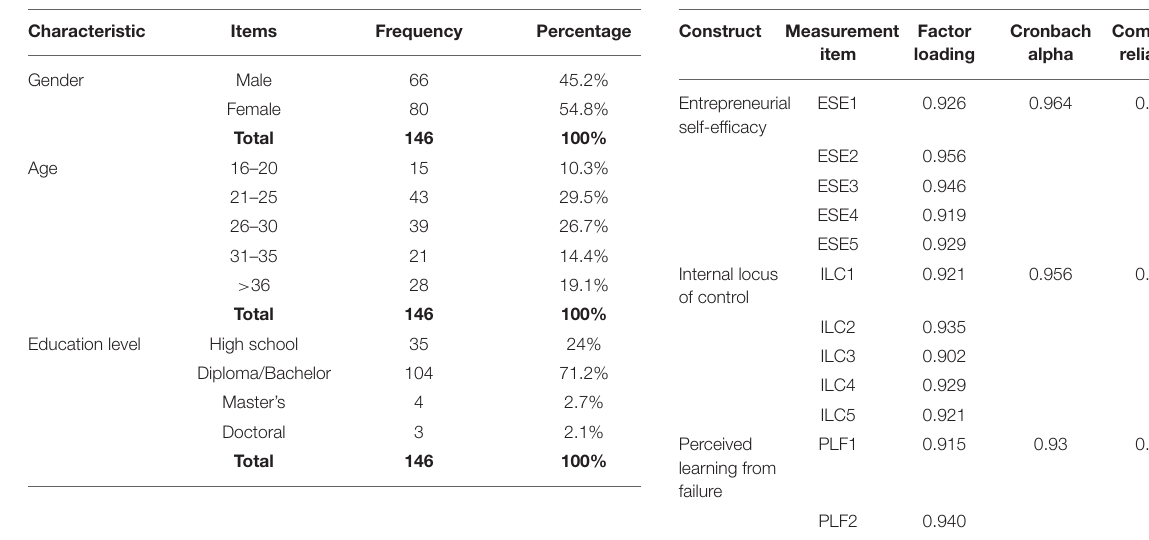
TABLE 3 | Sample demographics. TABLE 4 | Reliability analysis and convergent